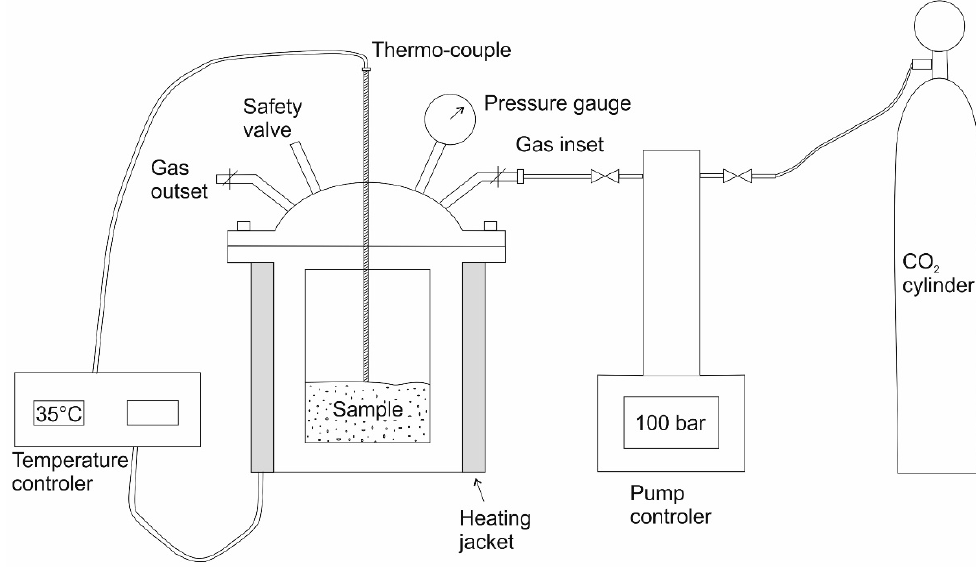
Figure 2. Schematic diagrams of the reaction vessel and auxiliary instruments (non-scaled).